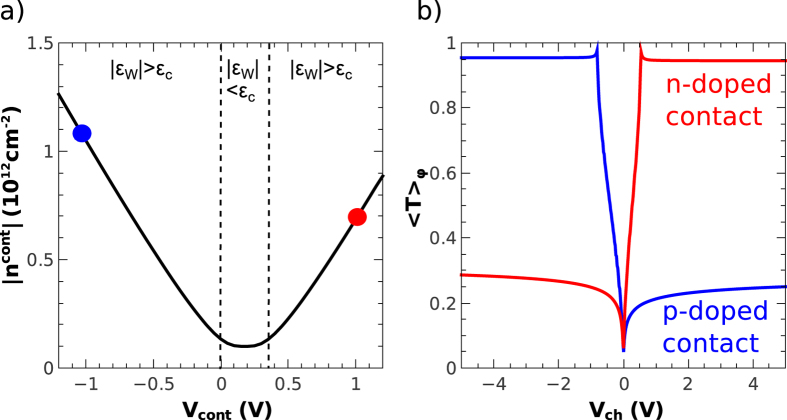
Panel (a) Carrier density ncont of the contacted graphene as a function of the voltage applied on the contact gate Vcont. The dotted lines delimitate the screened (ϵW > ϵc) regime and the unscreened (ϵW < ϵc) regime where the contact gate is poorly efficient. The ncont minimum is reached at Vcont = 0.2 V accordingly to the effective work function mismatch. Panel (b) Averaged transmission of the contact junction  with diffusive lead for two characteristic doping of the contacted graphene indicated by the dots of panel a) (n = −1.1 and n = 0.7 × 1012 cm−2).